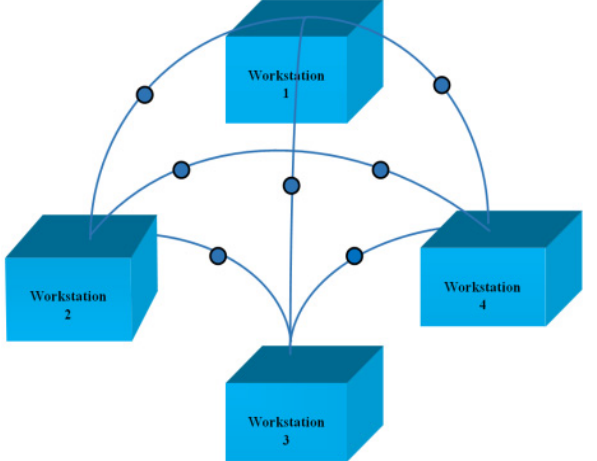
Figure 1. Automated in-plant logistics in industry 4.0 by intelligent throwing-catching robots at different workstations (using different altitude routes) . different workstations (using different altitude